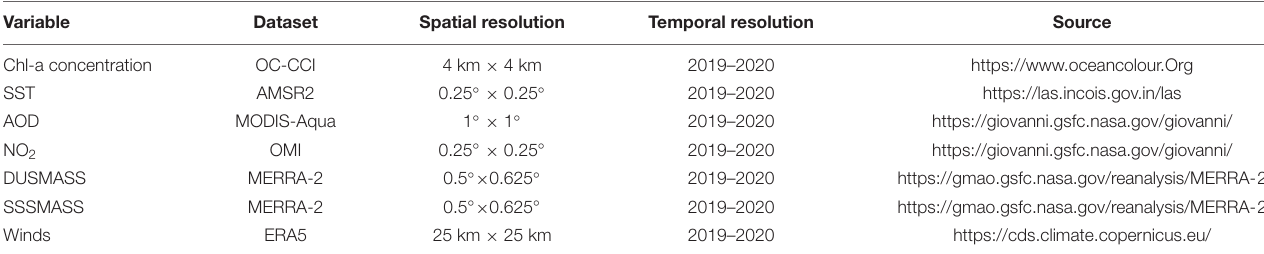
FIGURE 1 | The study domain of the North Indian Ocean (NIO) with the bathymetry and topography in shades (in meters). The continuous contour lines off the Somalia and Oman coasts and red boxes (B1, B2, and B3) in the Bay of Bengal (BoB) show the regions of vertical profile analysis. The location of the Research Moored Array for African–Asian–Australian Monsoon Analysis and Prediction (RAMA) buoy is marked with a star and the trajectory of Bio-Argo float is shown with a green curve. TABLE 1 | Summary of datasets used in the study.